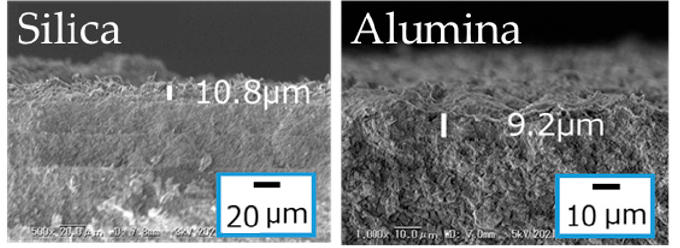
Figure 8. Thicknesses of CHA zeolite membranes synthesized on different porous substrates. (1 SiO 2 :0.8 TMAdaOH:0.8 HF:4.6 H 2 O, x wt% CHA seeds, 16 h at 423